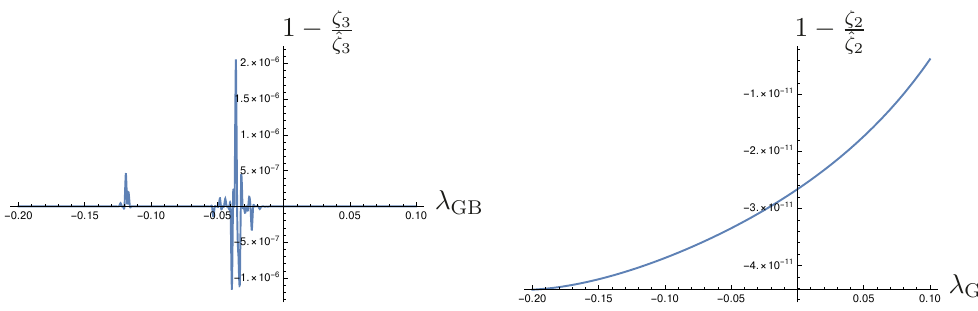
Figure 7 . Comparison of the bulk viscosity coefficient ζ ∆ , see (3.7), extracted from the sound waves dispersion relation and the corresponding coefficient ˆ ζ ∆ , see (4.18), extracted from the leading hydrodynamic contribution in the entropy production rate for the FLRW flow.